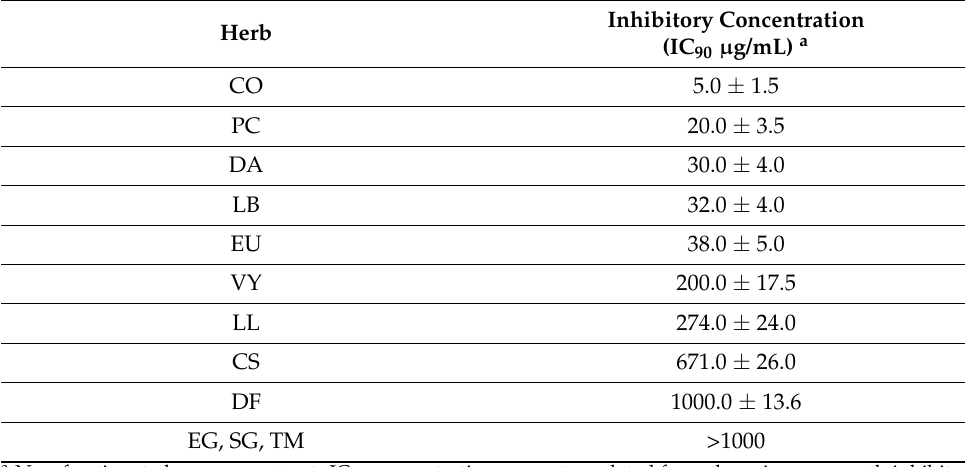
Table 4. Ranking of growth inhibitory efficacy of Chinese herbs by IC 90